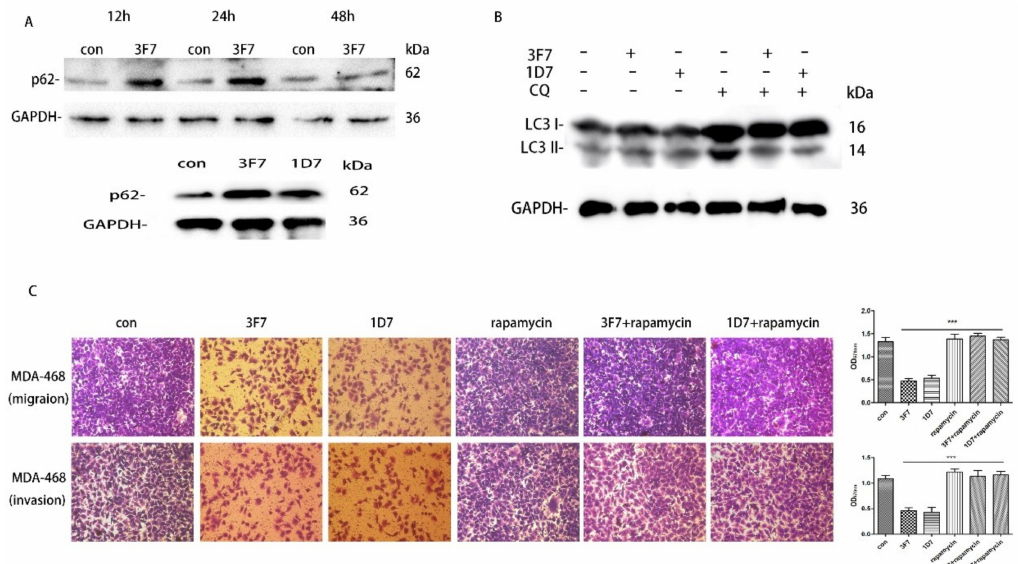
Figure 8. Autophagy participated in the inhibition of cell migration and invasion after treatment with 3F7: ( A ) MDA-MB-468 cells were treated with 3F7 (10 µ g/mL) or 1D7 (down) for 12, 24, and 48 h. p62 and GAPDH were detected by a Western blot analysis; ( B ) MDA-MB-468 cells were treated with 3F7 (10 µ g/mL) or 1D7 for 24 h, and LC3 and GAPDH were detected by a Western blot analysis; and ( C ) Rapamycin restored the inhibition of cell invasion (up) and migration (down) after treatment with 3F7 or 1D7 (100 × ). Rapamycin: autophagy stimulator. Data are shown as means ± SD and analyzed by t -test; NS, not significant; *** p < 0.001. Data are representative of at least three independent